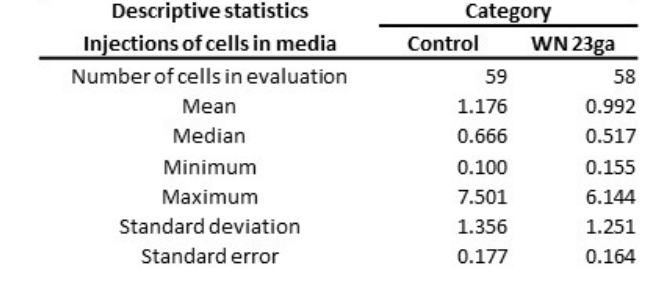
Figure 2. Analysis of Young’s modulus of cell injections by WN in capture fluid. Boxplots (medians, minimum, maximum) of the stiffness (kPa) measured by atomic force microscopy for controls and WN-injected pADSCs in capture fluid are depicted. The control (untreated) cell monolayers revealed no difference in stiffness when compared to the WN group. Descriptive statistics of Young’s moduli in the control and WN-injected cells in capture fluid. Medians with minimum and maximum, means, standard deviations, and standard errors of the mean of both groups are depicted. ns p > 0.05. Abbreviations: WN—Williams needle.